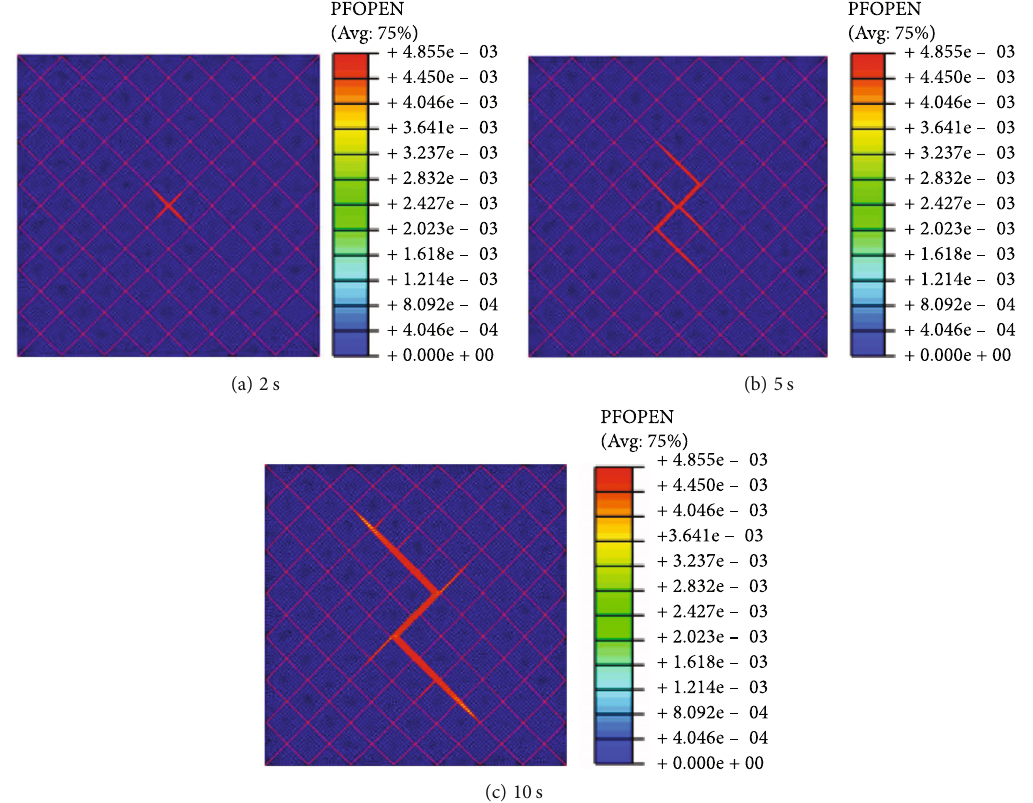
Figure 9: Main fracture opening distribution based on model II.